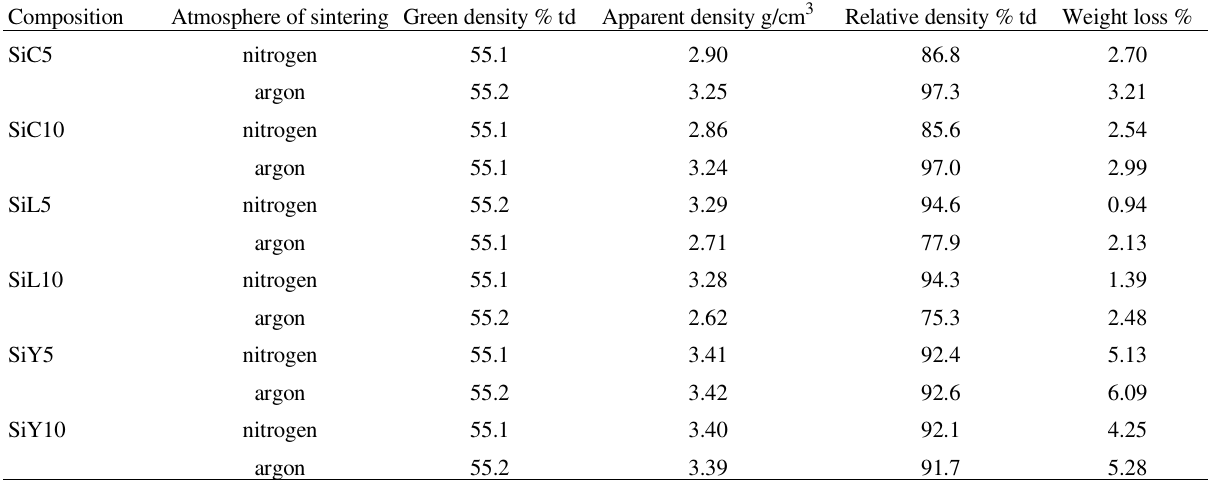
Table 2. Green density, sintered density and weight loss after furnace sintering of investigated compositions. Composition